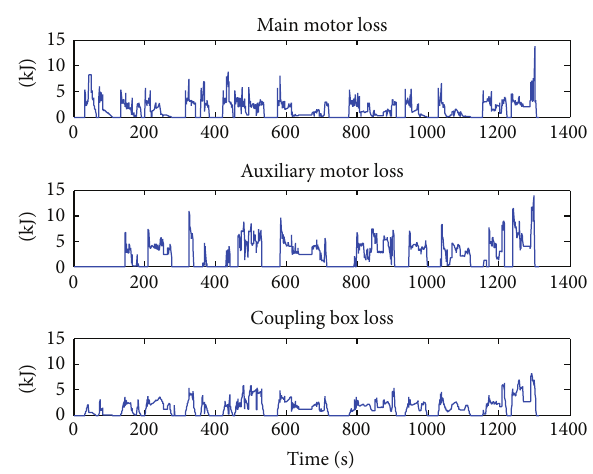
Figure 7: Energy-loss distribution for 𝛼 = 2